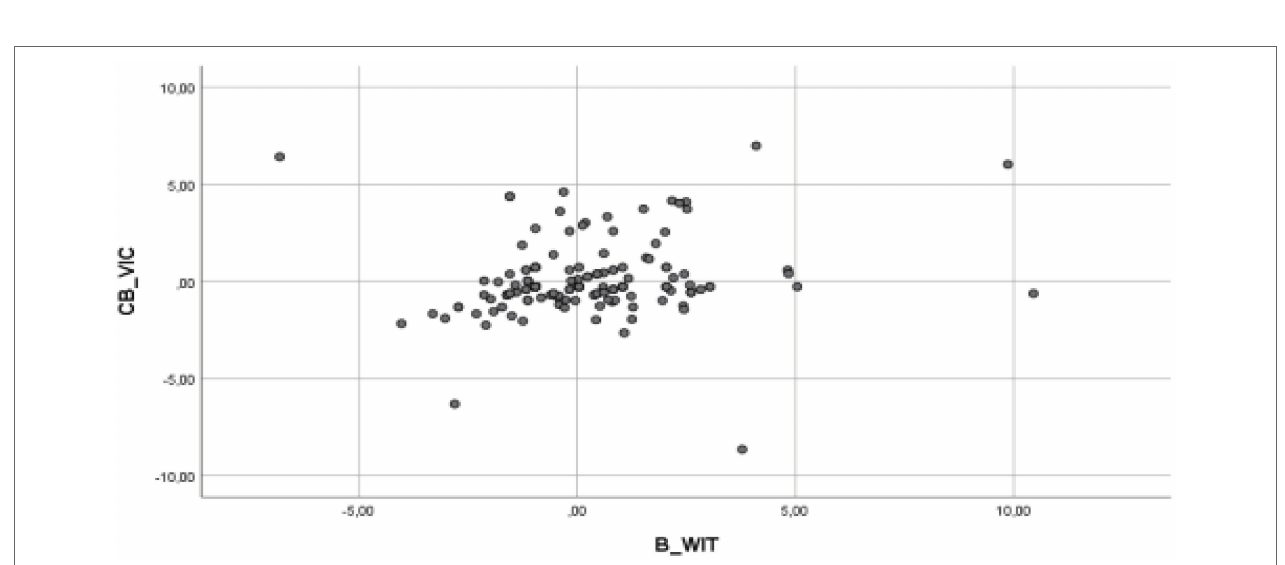
FIGURE 4 | Partial regression graphs of the cyberbullying role of victims criterion variable (CB_VIC), with the predictive variable the role of harassment of victims (B_VIC), included in the